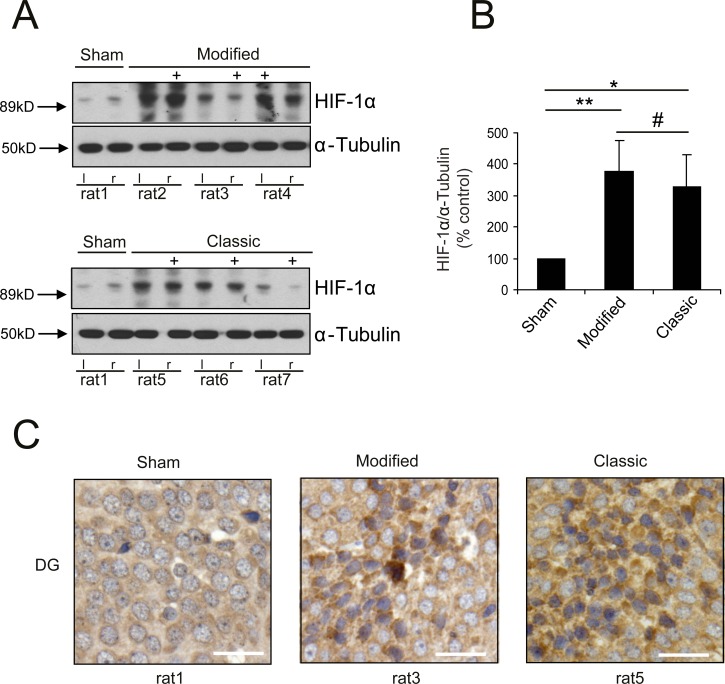
Analysis of HIF-1α-expression.Protein analysis for HIF-1α shows significant increase of HIF-1α-expression in hippocampal tissue 6h after SAH (A+B) independent from type of technique (Location of ICP-probe is hallmarked (+)). Immunohistochemical staining for HIF-1α demonstrates clear increase of HIF-1α expression in dentate gyrus compared to Sham animal (right lower corner: bar indicates 20 μm). (** p<0.01; * p<0.05; # p>0.05)